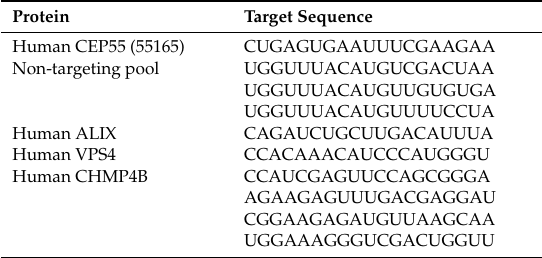
Table 1. siRNA oligonucleotide